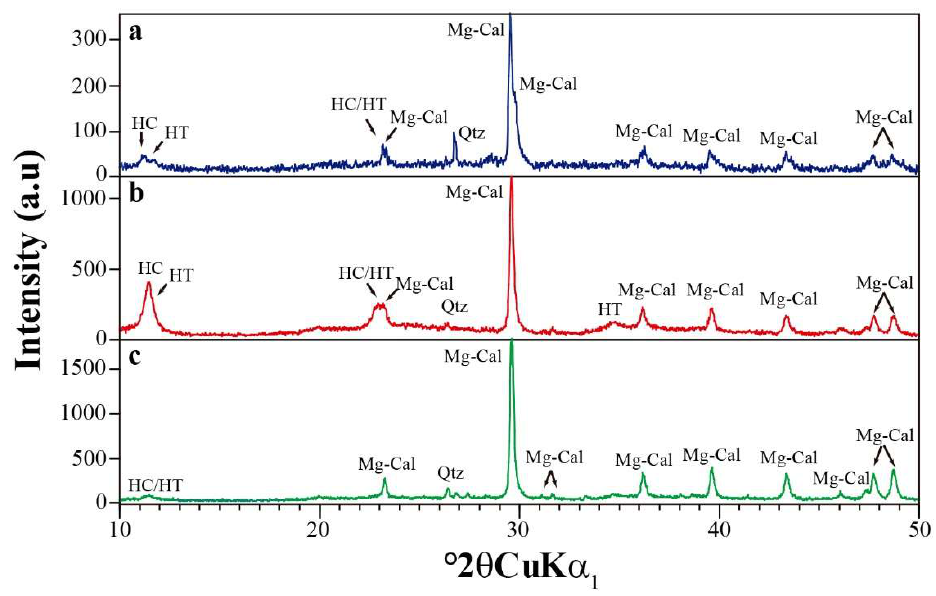
Figure 4. Photomicrographs showing the textural heterogeneity of historic lime mortars from Portilla Castle. ( a ) Mortar with rock fragments, lumps, and quartz grains. ( b ) Fragments of unburnt limestone and angular quartz grains. ( c ) Mortar with limestone fragments and quartz bearing lumps. ( d ) Mortar with a pure lump and charcoal fragment. Rx: rock fragment, Qtz: quartz, L: lump, U: unburnt, C: charcoal.